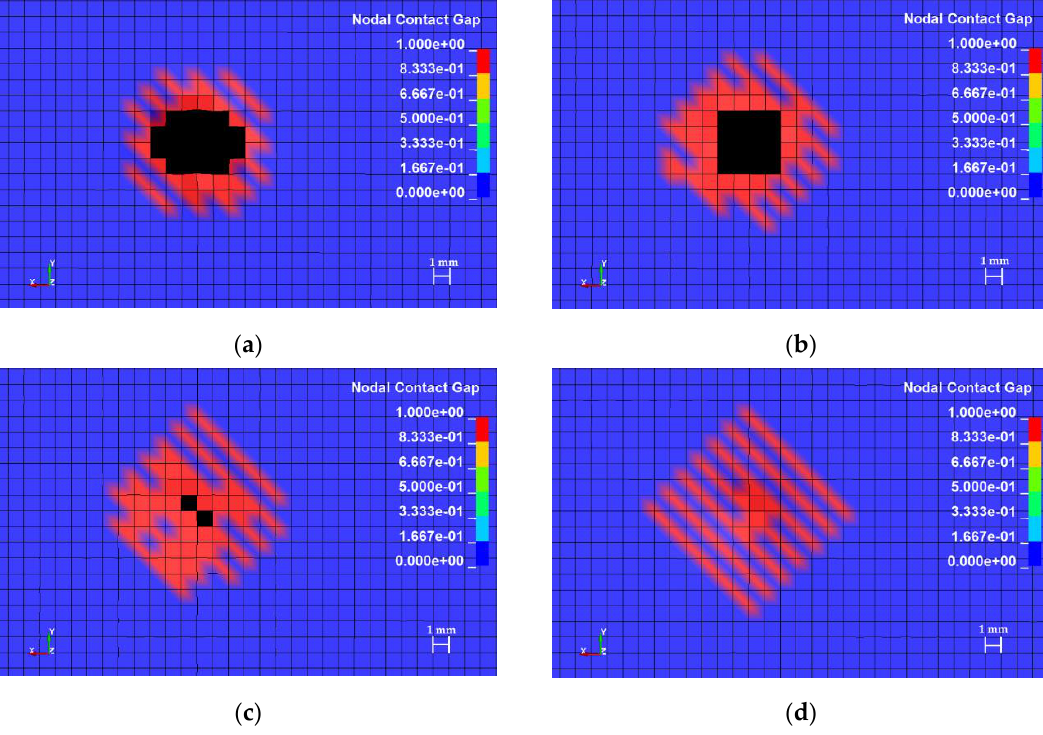
Figure 14. Colored maps of delamination areas after impact of the ogival striker between layers: ( a ) 1 and 2, ( b ) 5 and 6, ( c ) 7 and 8, ( d ) 13 and 14.